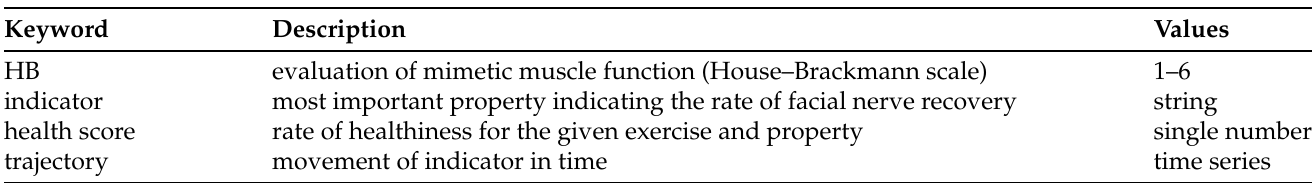
Table 9. Terminology overview.